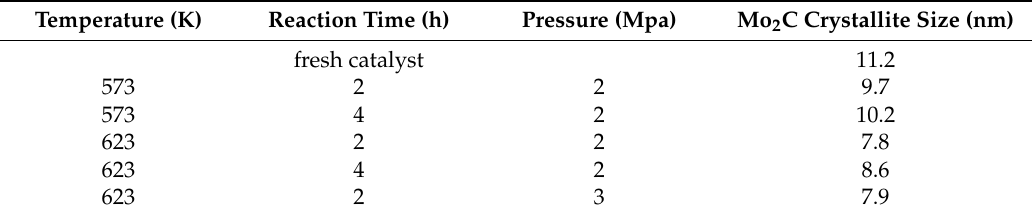
Table 2. Mo 2 C crystallite size of the fresh and spent catalysts determined by X-ray Diffraction (XRD). Temperature